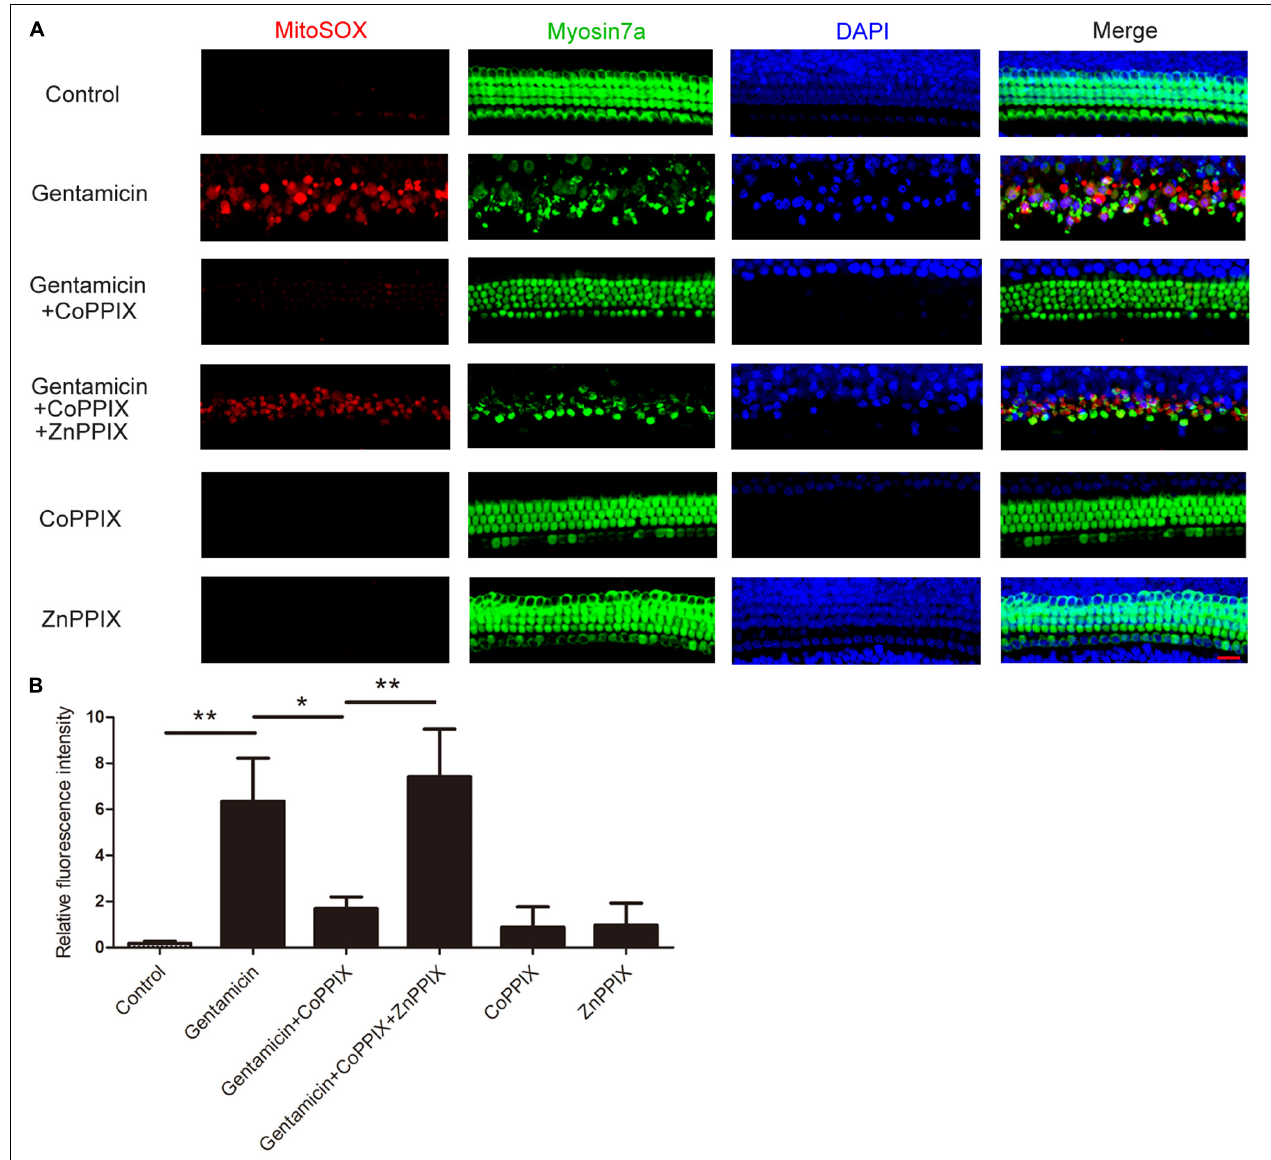
FIGURE 5 | Induction of heme oxygenase-1 (HO-1) by CoPPIX reduces intracellular reactive oxygen species (ROS) levels, and ZnPPIX increases intracellular ROS levels. (A) Representative micrographs showing MitoSOX Red immunostaining. The organs of Corti were pretreated with CoPPIX (5 µ M) in the presence or absence of ZnPPIX (20 µ M) for 12 h and then further incubated with 0.6mM gentamicin for 24 h. Scale bar = 20 µ m. (B) Quantification of relative fluorescence intensities of ROS in each group (* P < 0.05 and ** P < 0.01, n =